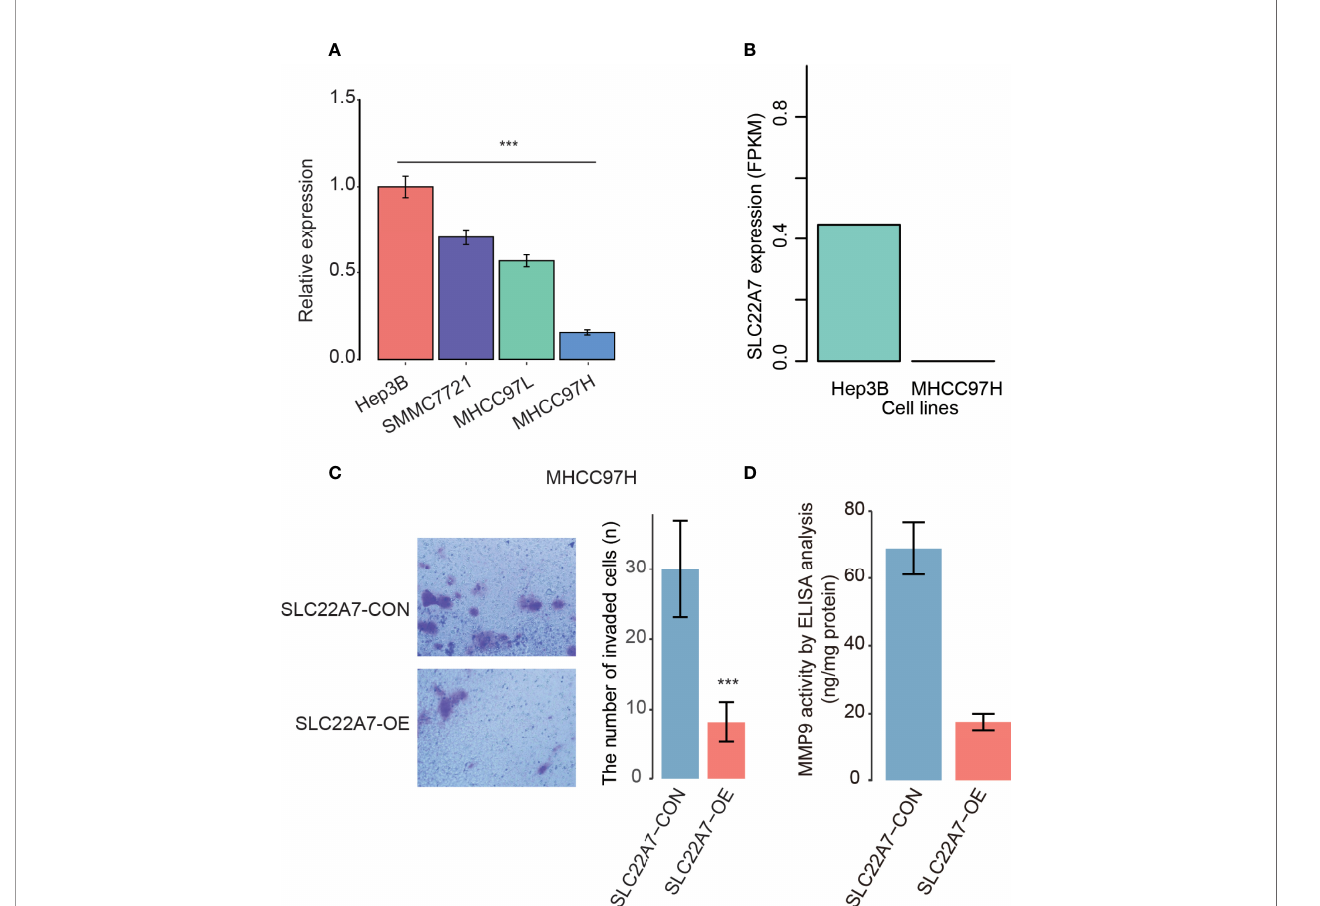
FIGURE 8 | The SLC22A7 expression in HCC cell lines. (A) The SLC22A7 expression levels detected by qRT-PCR. The expression levels were normalized to Hep3B. (B) The SLC22A7 expression levels quanti fi ed by RNA-seq data. (C) The number of invaded cells in SLC22A7-overexpression (SLC22A7-OE) and control (SLC22A7-CON) MHCC97H cell lines. (D) MMP9 activity in SLC22A7-OE and SLC22A7-CON groups by ELISA analysis. ***: P-value <